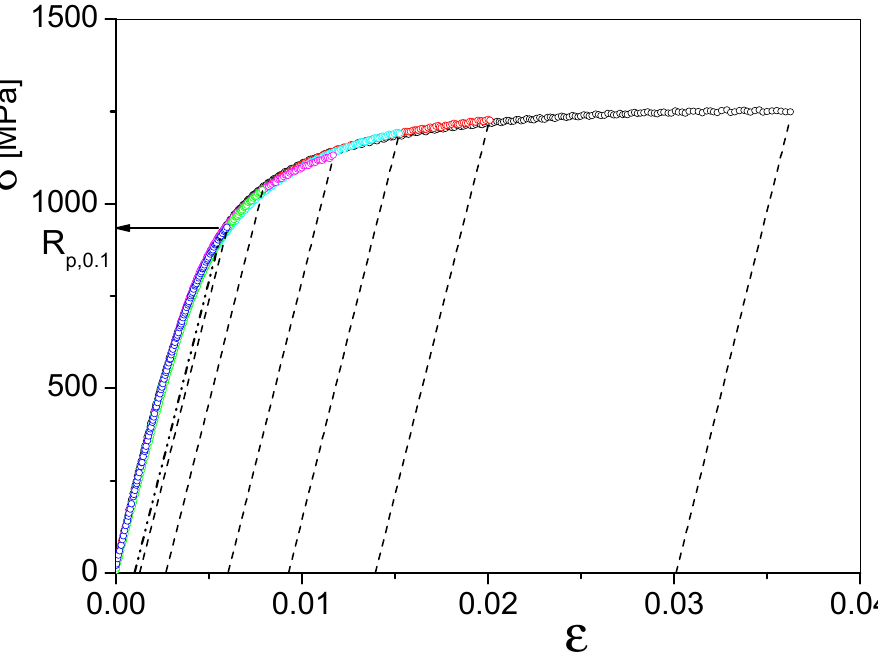
Figure 1. The true stress, σ , versus true strain, ε , curves of the deformed specimens. The material fractured at ε = 0.034 plastic strain. The different colors ending at the dashed lines, indicating unloading, correspond to the stress–strain curves of the individual specimens. The dash–dot–dot line is at ε = 0.001 and the corresponding stress value is taken as the proof-stress, R p,0.1 = 930 MPa.